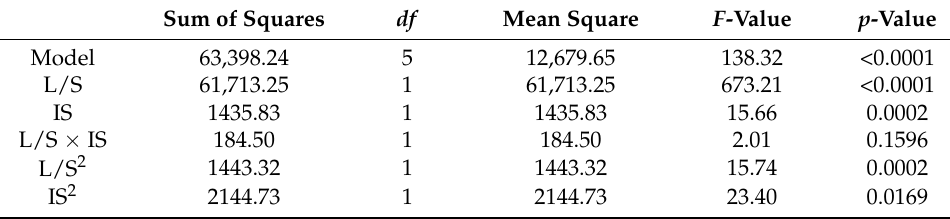
Table 4. Analysis of variance for the process yield model and individual